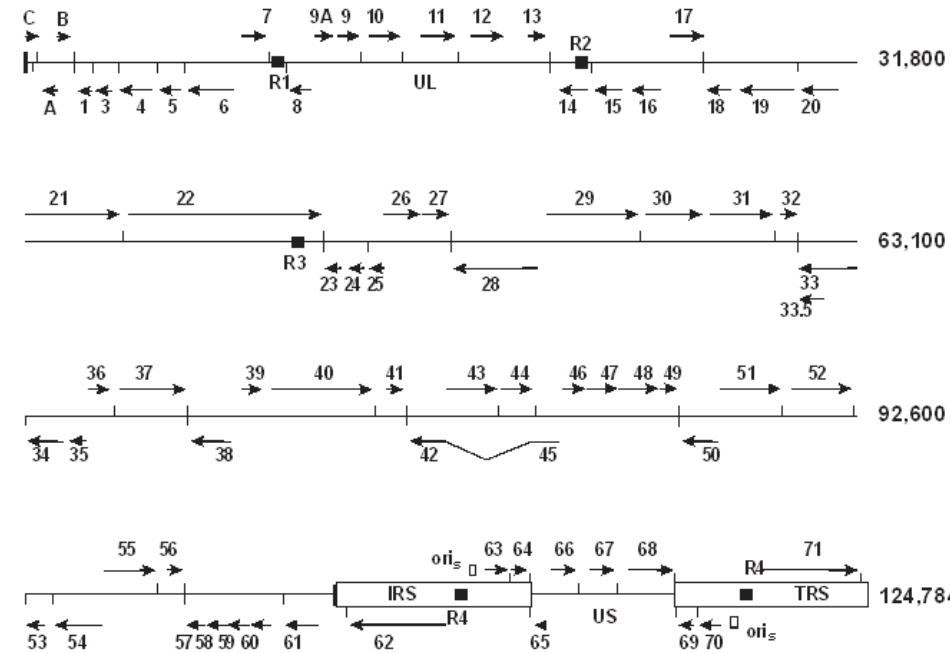
Figure 2. The SVV genome includes 73 ORFs, each of which are designated as arrows indicating the site on each DNA strand. The R1, R2, R3, and R4 direct repeats are indicated as boxes. The VZV genome has a similar gene map except for the left end of the viral DNA. VZV ORFs have the same nomenclature as their SVV homologs, while unique SVV ORFs are designated with letters (A, B, C). Vertical lines indicate poly A sites. Reprinted from Current Topics in Microbiology and Immunology [15] with permission from the publisher.